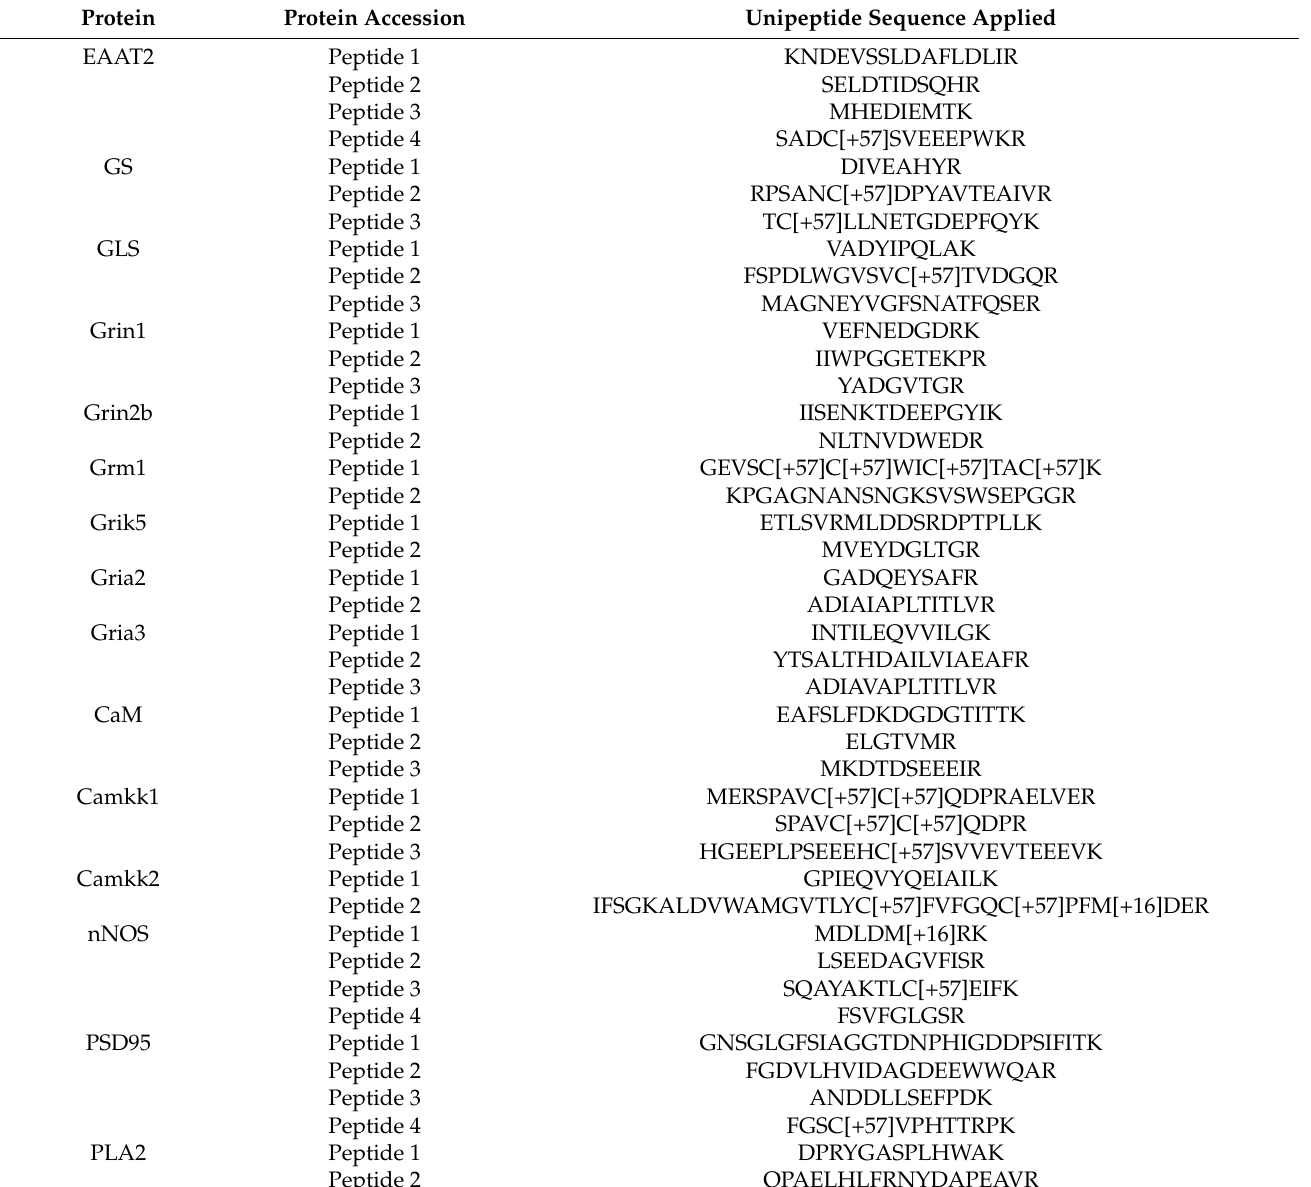
Table 2. The characteristic peptides of targeted